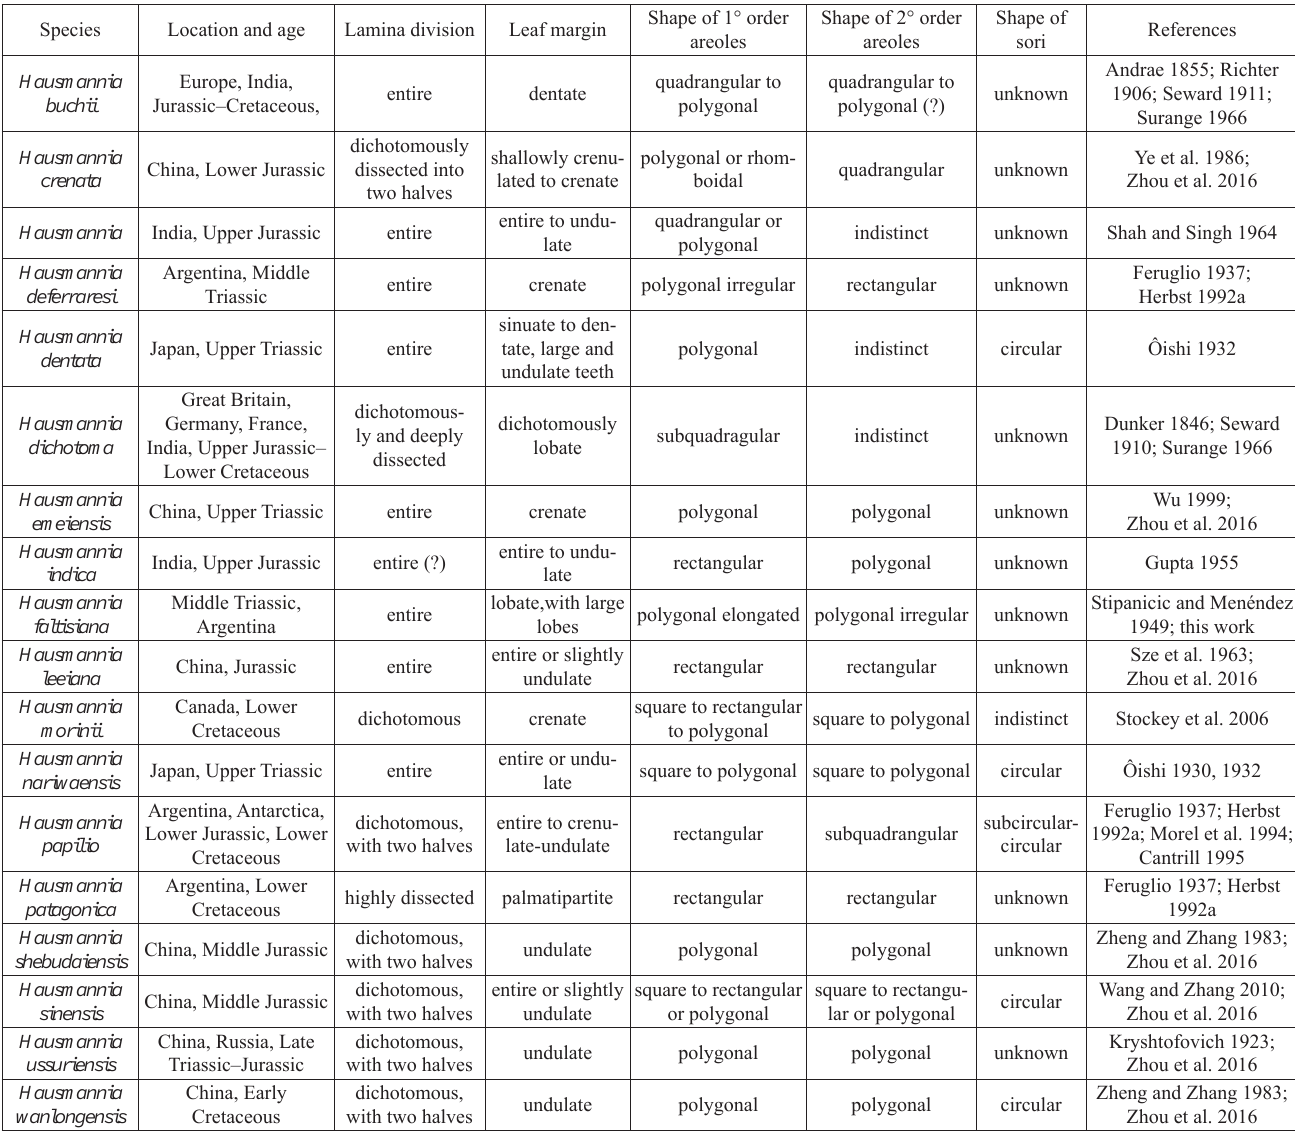
Table 2. Comparative table of the most representative species of the genus Hausmannia .